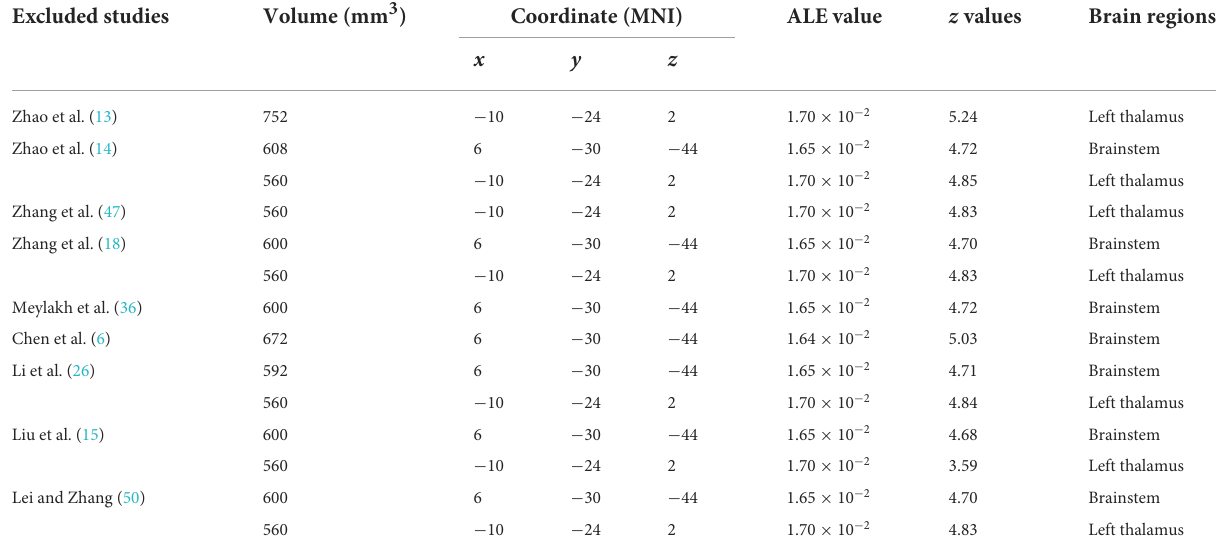
TABLE 5 Sensitivity analysis of ReHo in migraine patients by ALE